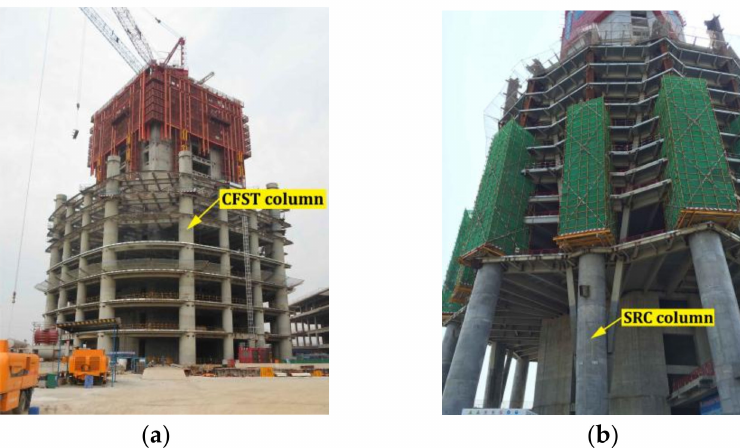
Figure 1. Mega columns in practical engineering. ( a ) Concrete-filled steel tubular (CFST) columns; and ( b ) steel reinforced concrete (SRC)